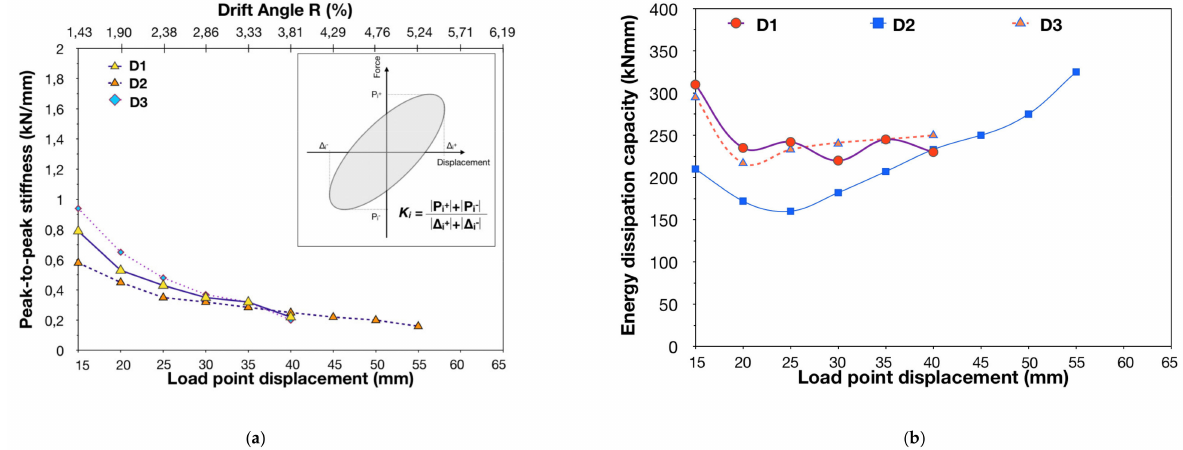
Figure 5. Plots of ( a ) peak-to-peak stiffness versus displacement and ( b ) energy dissipation capacity versus displacement of the subassemblages D 1, D 2, and D 3.